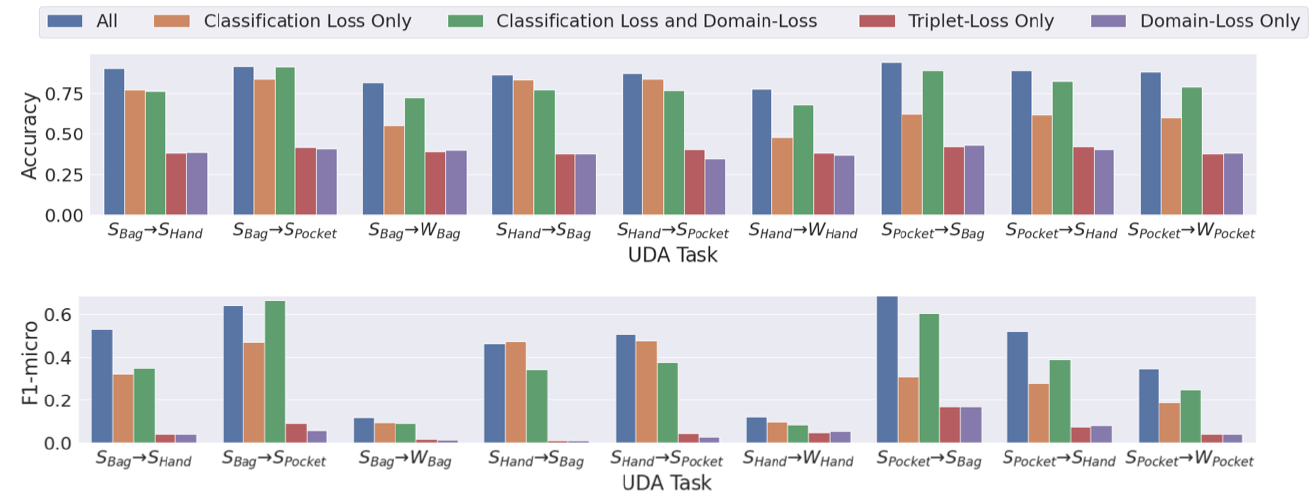
Figure 11. Ablation study, evaluating the contribution of Triple-DARE ’s each